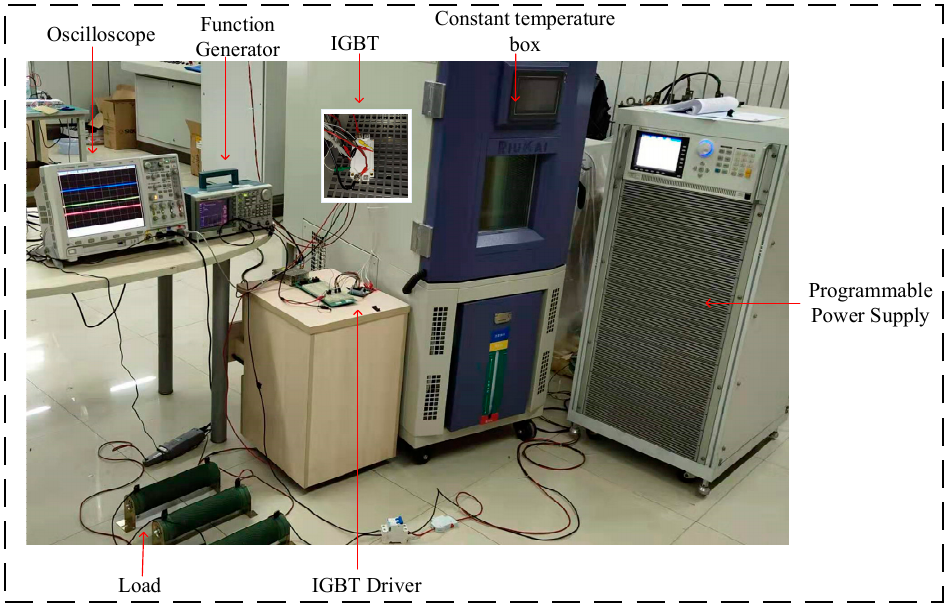
Figure 8. Physical diagram of the test system.